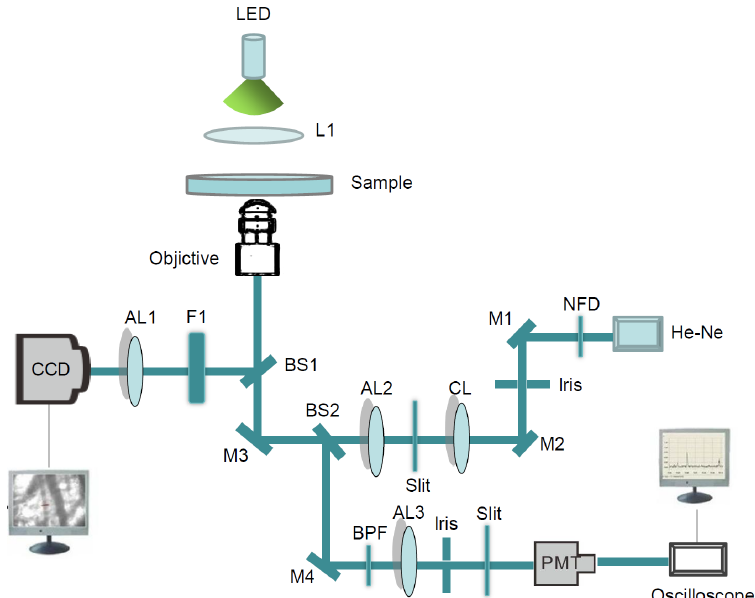
Fig. 2. The overall structure of the ¯rst in vivo °uorescent °ow cytometry. L1, condenser lens; OL, microscope objective lens (40 (cid:2) , 0.6 numerical aperture, in¯nity corrected); BS1, BS2, dichroic beam splitters; AL1 – AL3, achromats; CL, cylindrical lens; M1 – M4, mirrors; NDF, neutral-density ¯lter; BPF, bandpass ¯lter; PMT, photomultiplier two cell populations labeled with di®erent markers.